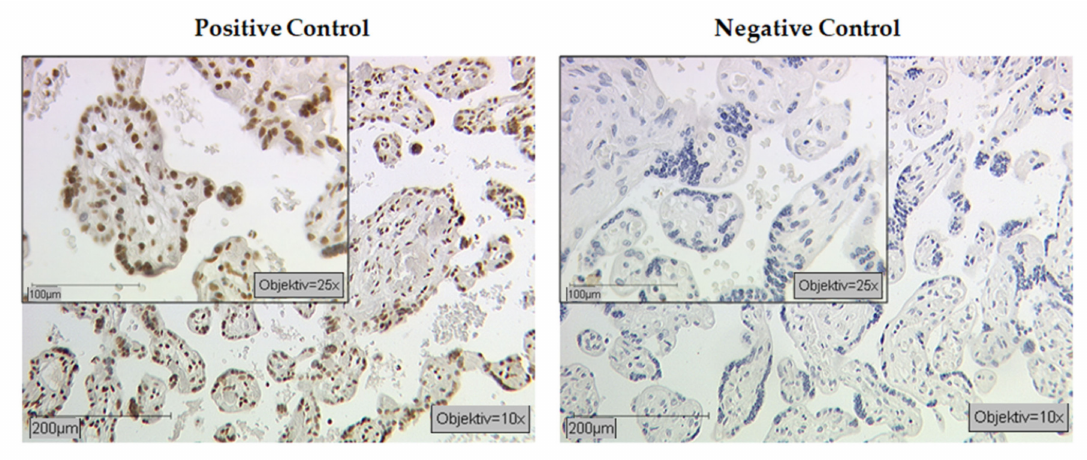
Figure A1. Positive and negative controls of H3K4me3 staining: We used the term placental villous tissue for positive and negative